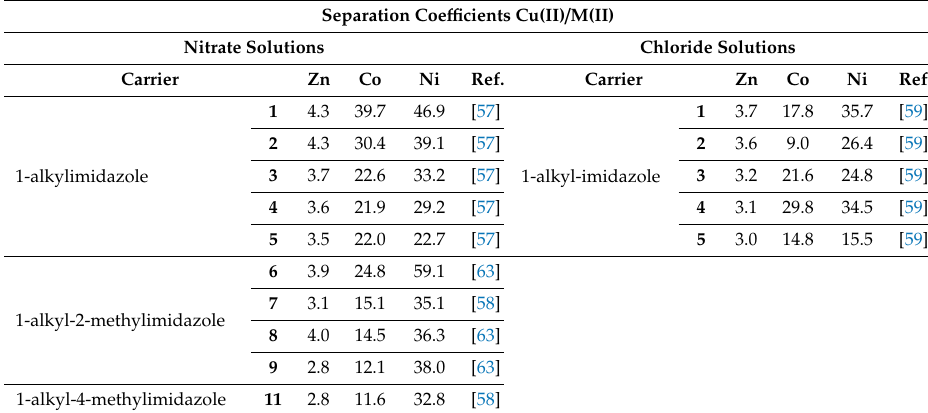
Table 7. The copper(II) separation coe ffi cients in relation to Zn(II), Co(II), and Ni(II) from 4-component Cu–Zn–Co–Ni equimolar solutions after a 24-h transport.